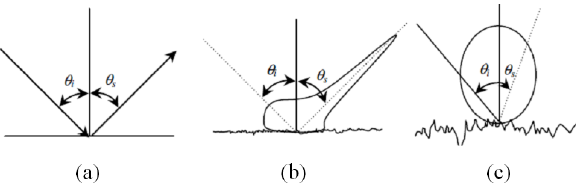
Figure 4. Types of reflectance for various grades of surface rough- ness